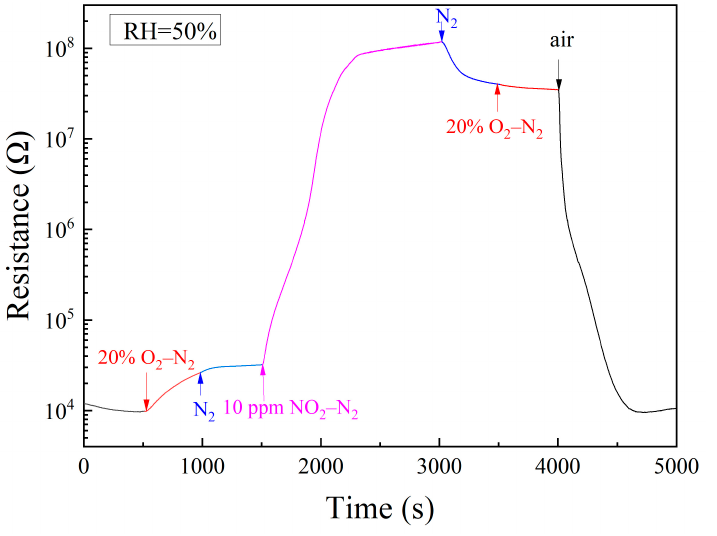
Figure 5. Room-temperature resistance responses to a sequence of atmospheres: air, 20% O 2 –N 2 , N 2 , 10 ppm NO 2 –N 2 , N 2 , 20% O 2 –N 2 , and air for a sample of 1 wt% Pt–5 wt% Au–SnO 2 sintered at 950 °C.